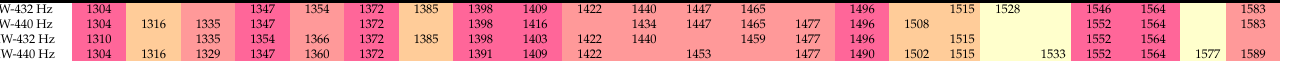
Table 2. Water absorbance bands (WABs) prominent for distinguishing samples perturbed by sound from the ones used as a control (before sound perturbation). From yellow to red, repeatability of the same band activation increases in the 4 displayed datasets, where most consistent and notable water matrix coordinates (WAMACS) were shown in darker color.